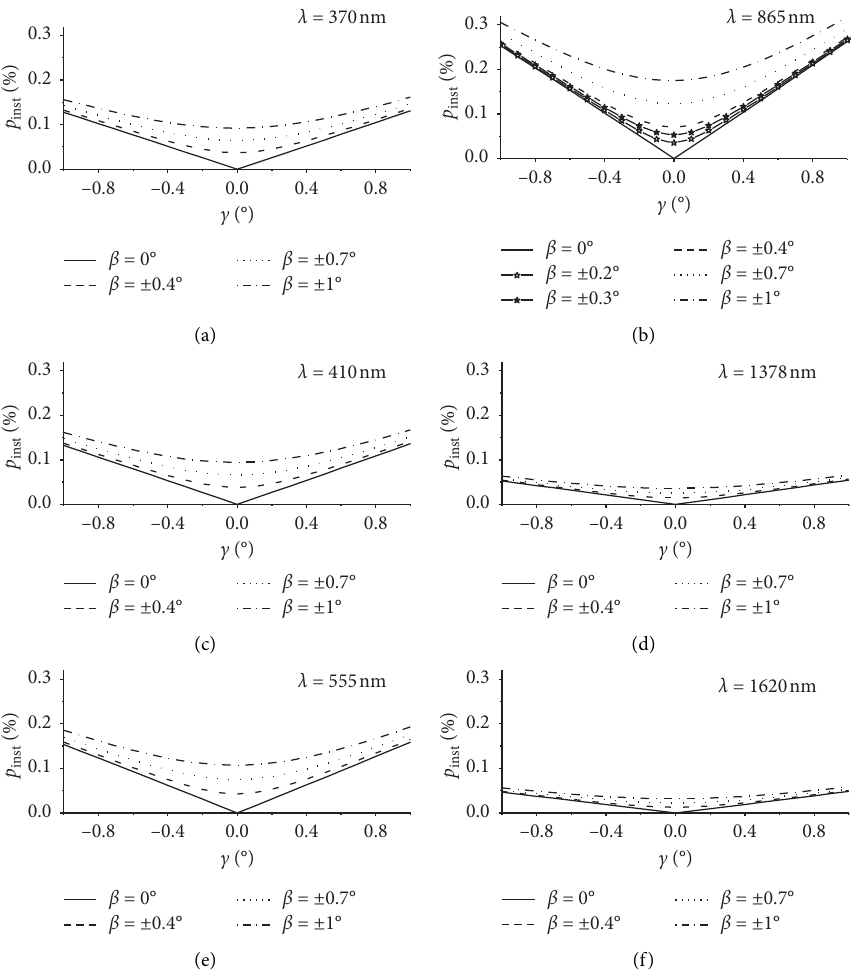
Figure 7: The dependence of the boundary value of the degree p axes 1 and 2 (as shown in Figure